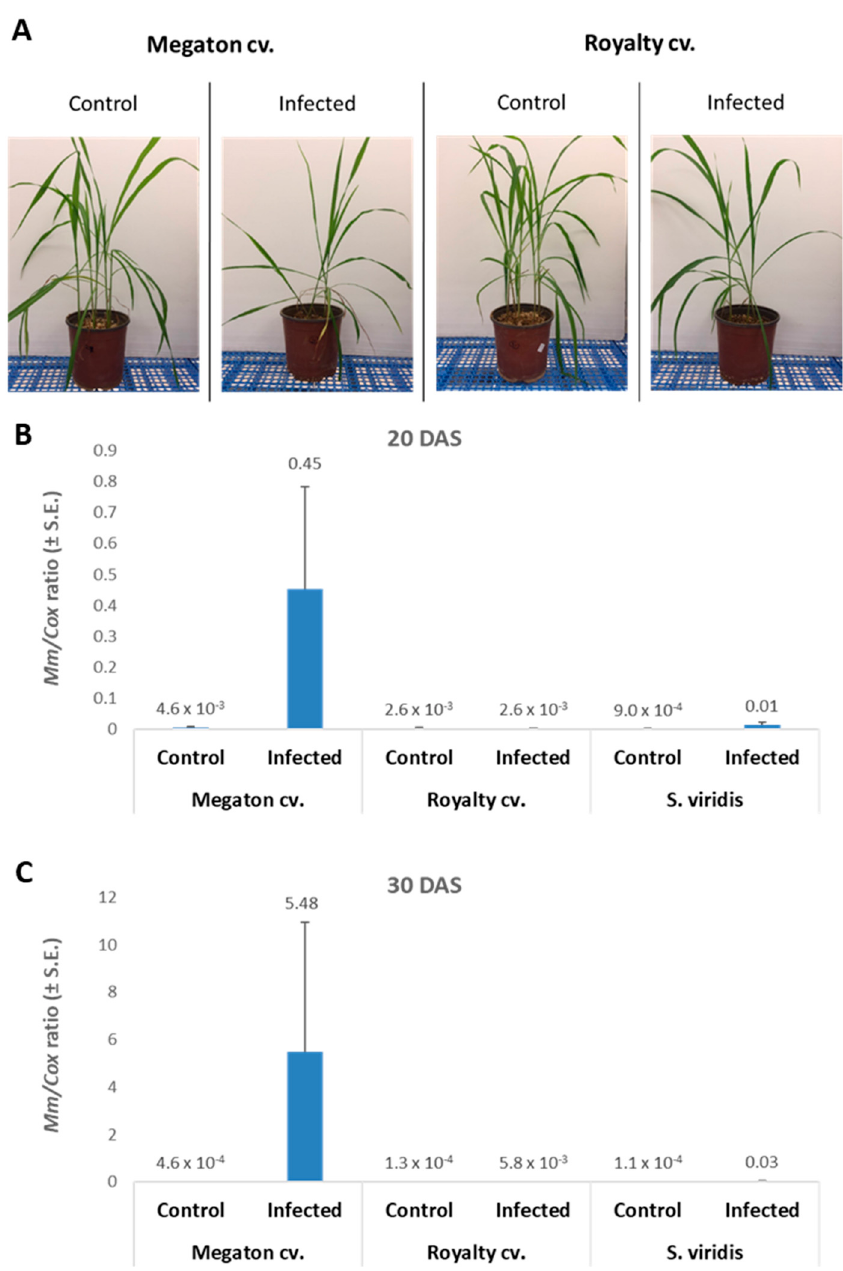
Figure 8. Seedling pathogenicity assay: qPCR analysis. A . Pictures of representative plants from the experiment described in Figure 6 were taken 30 DAS. The plants were tested for the presence of M. maydis DNA inside their root tissues 20 ( B ) and 30 ( C ) post-sowing. The maize varieties (Megaton cv. and Royalty cv.) evaluation was compared to the pathogen DNA variations within the roots of Setaria viridis (green foxtail), a recently discovered new host of this fungus [18]. The S. viridis plants were grown under the same condition for the same periods as the maize cultivars. The y -axis parameters are M. maydis relative DNA ( Mm ) levels normalized to the cytochrome c oxidase ( Cox ) DNA. Vertical upper bars signify the standard error of the mean of three repeats